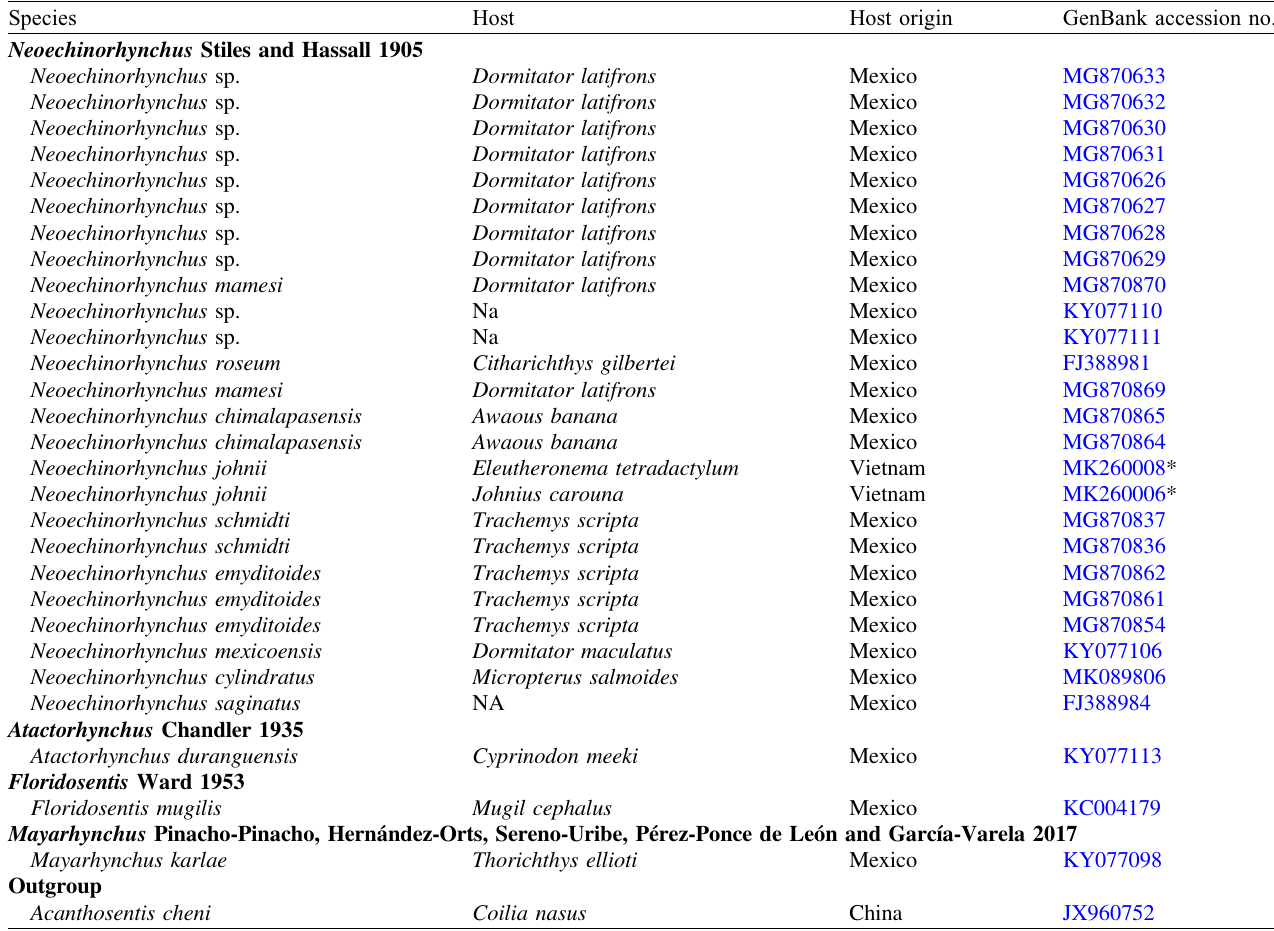
Table 6. Acanthocephala species, origin and GenBank accession numbers used for phylogenetic analysis based on the ITS1-5.8S-ITS2 gene cluster. Sequences marked with an asterisk were obtained in this study. Na = not available. Species